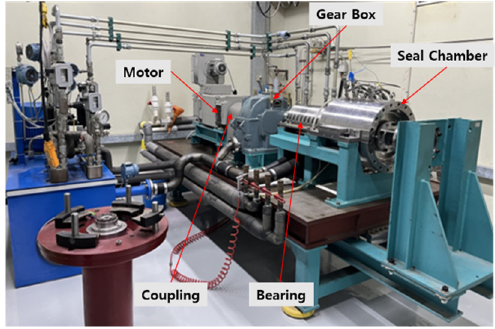
36 Table 4. Measured and simulated leakage rate according to the change of the outer pressure. Outer Pressure [bar]